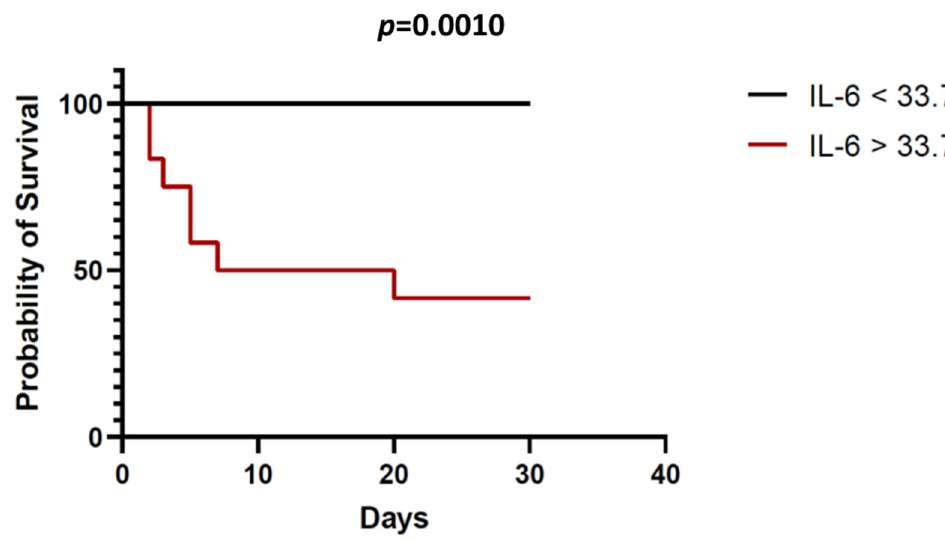
Figure 5. Kaplan–Meier survival analysis. Patients with IL-6 levels at admission >33.7 pg/mL had significantly lower 30-day survival in comparison to those patients with IL-6 levels < 33.7 pg/mL. Table 4. Simple logistic regression analysis (A) and multiple logistic regression model (B) to predict mortality in hemodialysis patients with SARS ‐ CoV ‐ 2 pneumonia.